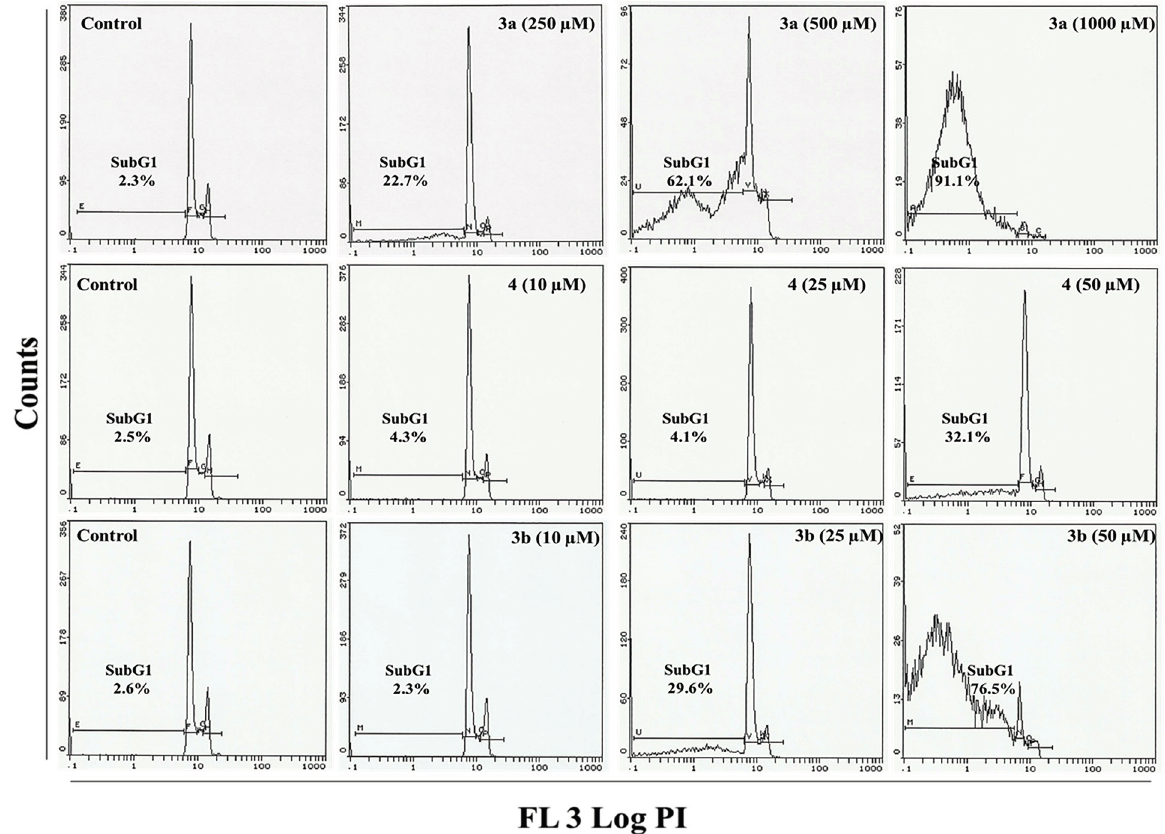
Figure 5. Flow cytometry images of treated MCF-7 cells. Flow cytometry images depicting changes in cell cycle progression in MCF-7 cells exposed to compounds 3a , 3b and 4 for 24 h. Sub-G1 indicates the cells undergoing